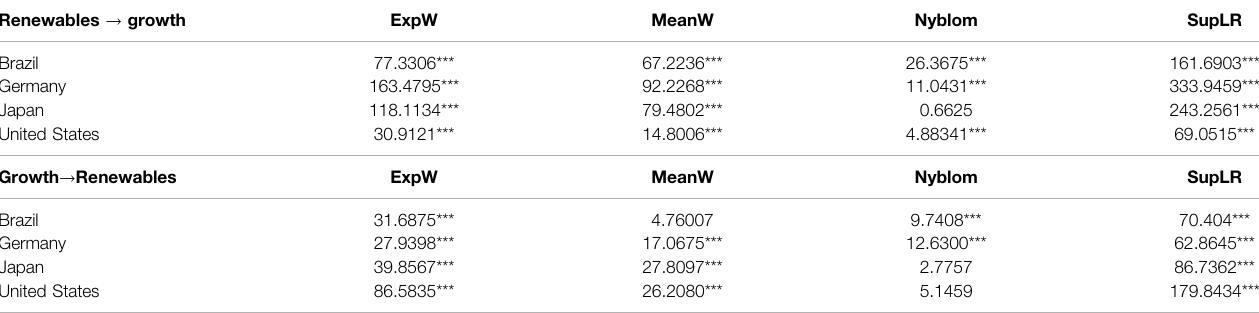
TABLE 2 | Results of Rossi-Wang causality